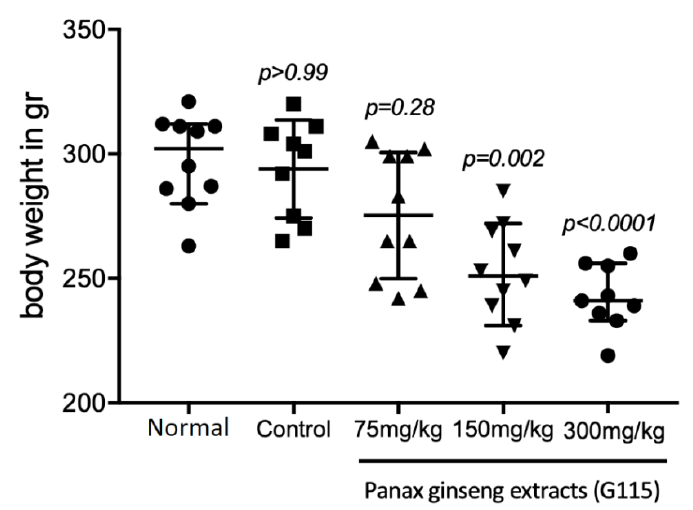
Figure 3. Body weight changes by Panax ginseng extracts .